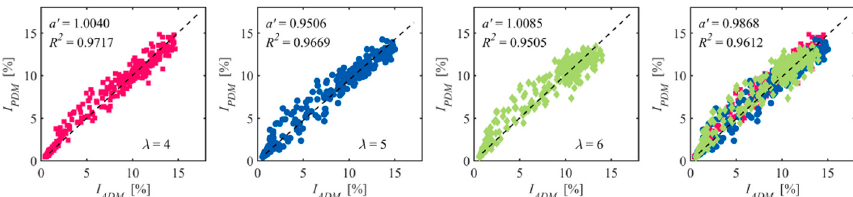
Figure 17. Relationship between the driving modes in terms of the wake turbulence intensity under various tip speed ratios and the UIF condition.